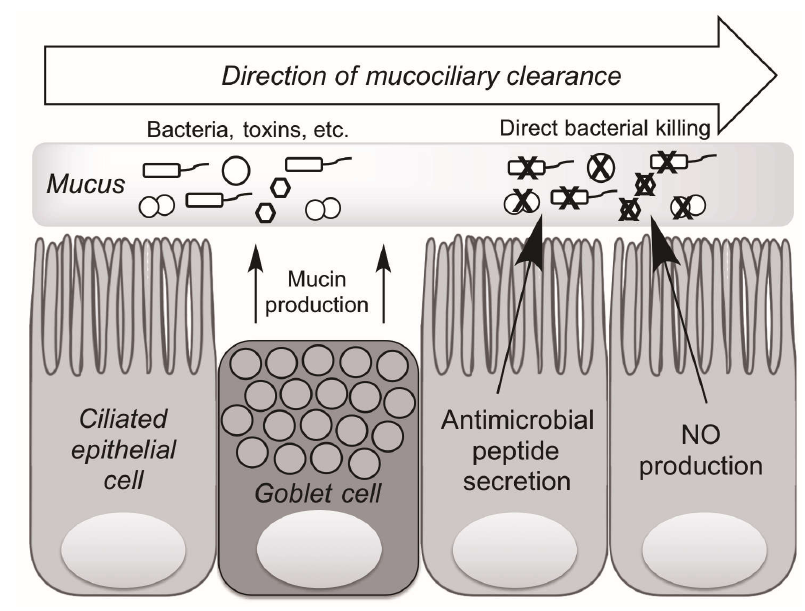
Figure 2. Mechanisms of upper airway innate immunity. Ciliated epithelial and goblet cells work in concert to rid the airway epithelium of foreign pathogens and other toxins through a process known as mucociliary clearance (MCC). Goblet cells secrete mucin that physically traps bacteria and other toxins while ciliated epithelial cells beat in a coordinated fashion to expel trapped pathogens from the airway. Ciliated cells also produce antimicrobial peptides and nitric oxide (NO), which both are directly bactericidal. NO also results in increased ciliary beat frequency, enhancing